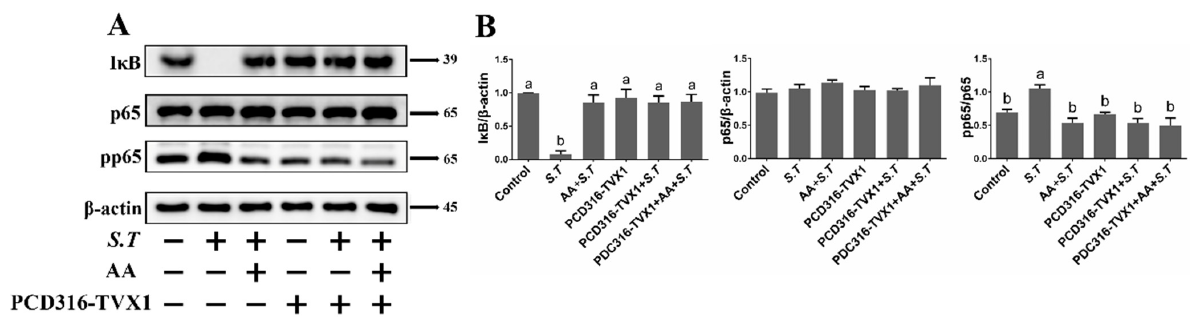
Figure 5. Effect of PCD316-TVX1 on AA Activation of the NF- κ B Pathway in S.T -infected Microglia. Western blotting detection of NF- κ B pathway protein changes in microglia. ( A ) Microglia were transfected with PCD316-TVX1 plasmid. Twenty-four hours later, cells were pre-treated with AA for one hour, then infected with S.T , and proteins were extracted for analysis. ( B ) NF- κ B pathway protein grayscale images (Different letters represent significant differences, p < 0.05, n = 3).